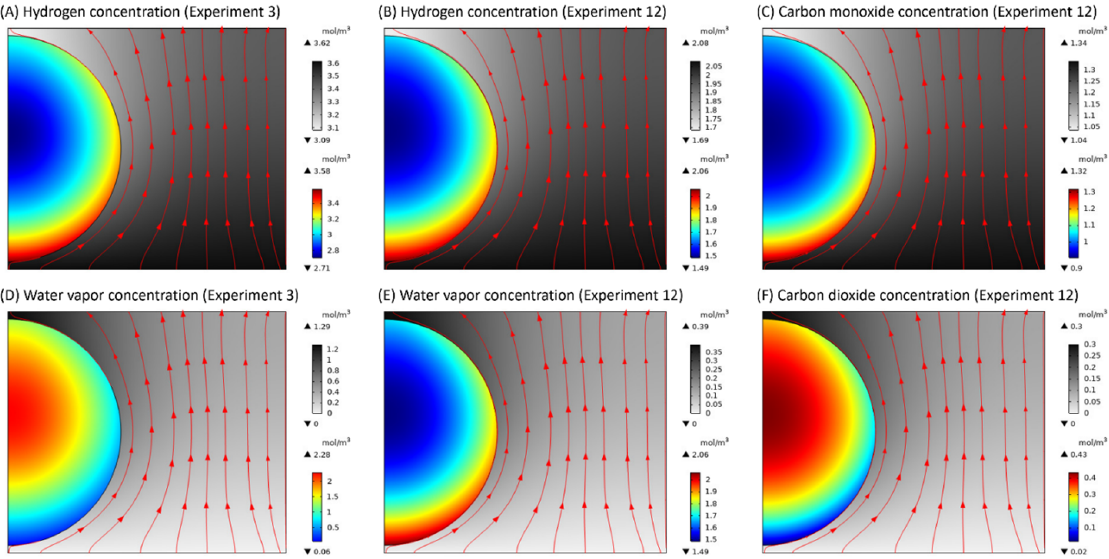
Figure 15. Local concentration profiles of gaseous species and bulk velocity streamlines for experi- ments with H 2 gas mixture ( A , D ) and H 2 /CO = 56/36 gas mixture ( B , C , E , F ) at X = 0.5.